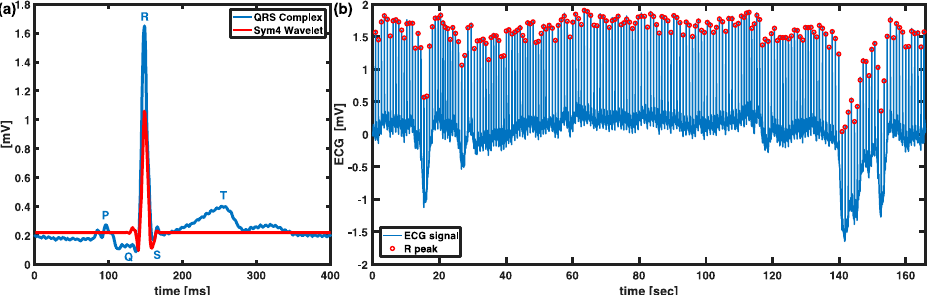
Figure 2. R peak detection technique. ( a ) Sym4 resembles the QRS complex that can be used for the wavelet transform. ( b ) A representative raw ECG signal with extracted R peaks in red circles.